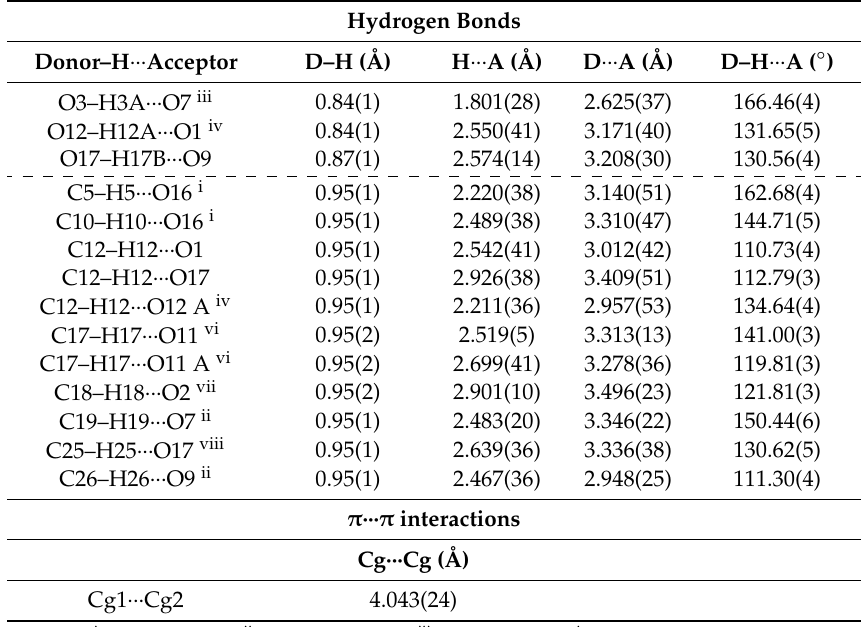
Table 3. The geometry of noncovalent interactions in complex 1 .